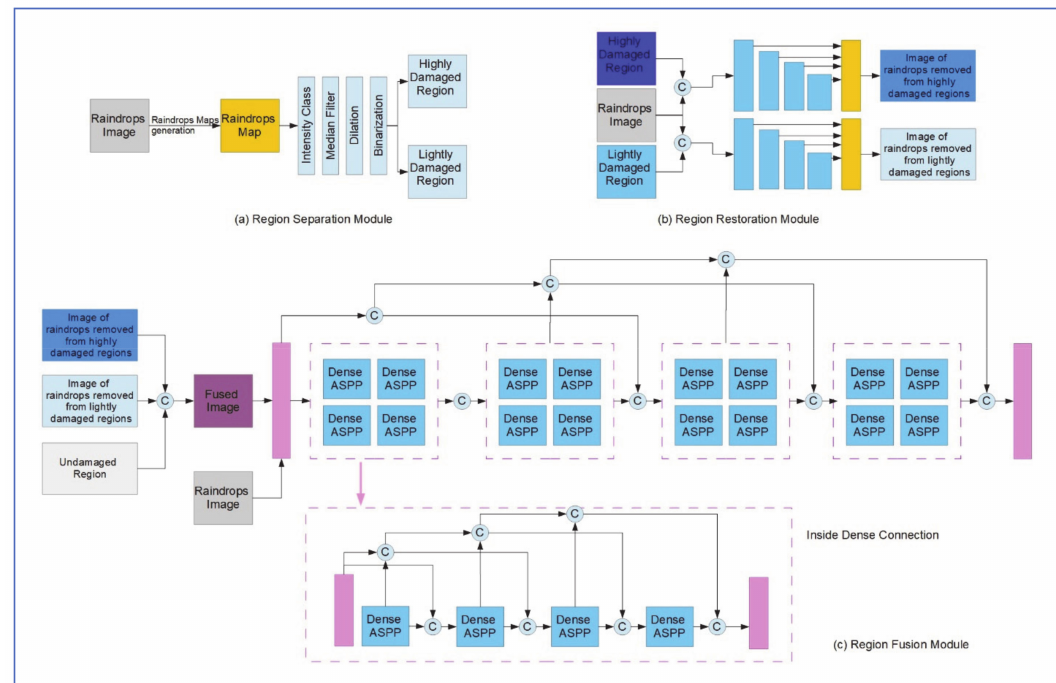
Figure 27. Structure of raindrop removal system with Separation-Restoration-Fusion approach, as proposed by Ren et al.